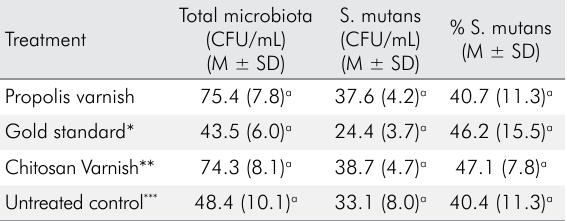
Table 1. Effects of the treatment with experimental and control varnishes on total oral microbiota and Streptococcus mutans counts in rats submitted to a high cariogenic challenge for four weeks. The values are expressed as mean (standard deviation).